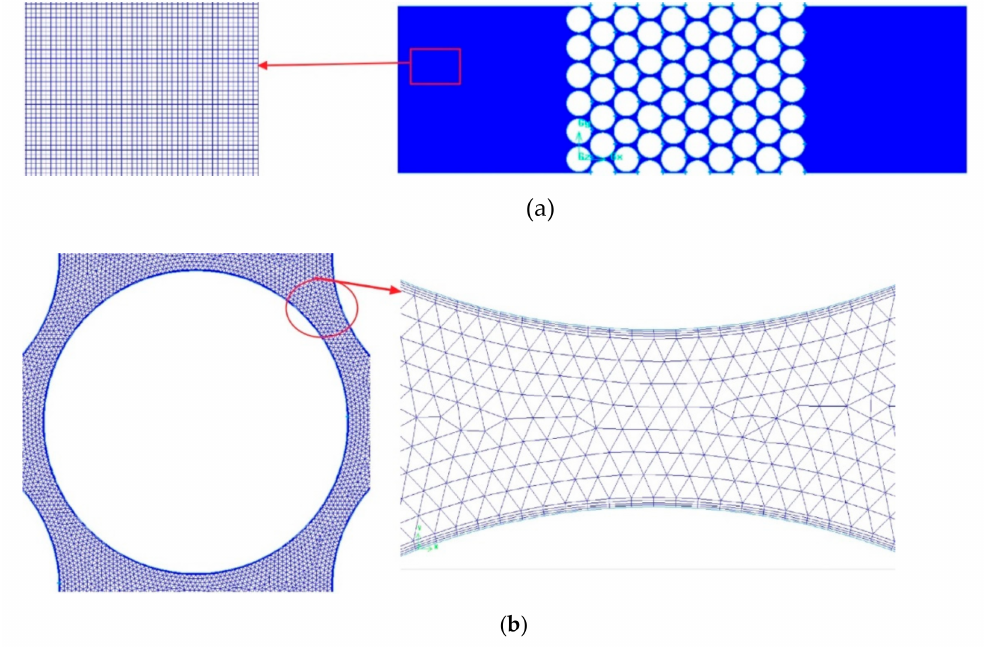
Figure 2. Grid generation of the 2D tube bank model. ( a ) represents the structured grid in upstream and downstream. ( b ) represents the unstructured grid and the boundary layer mesh in bristles pack.